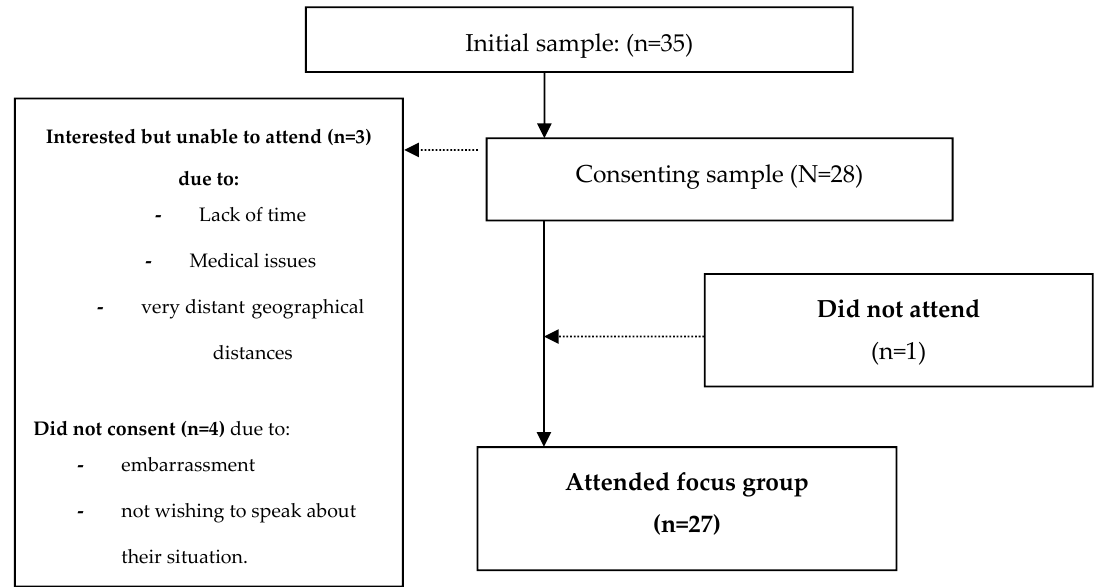
Figure 1. Recruitment process and study participation 146